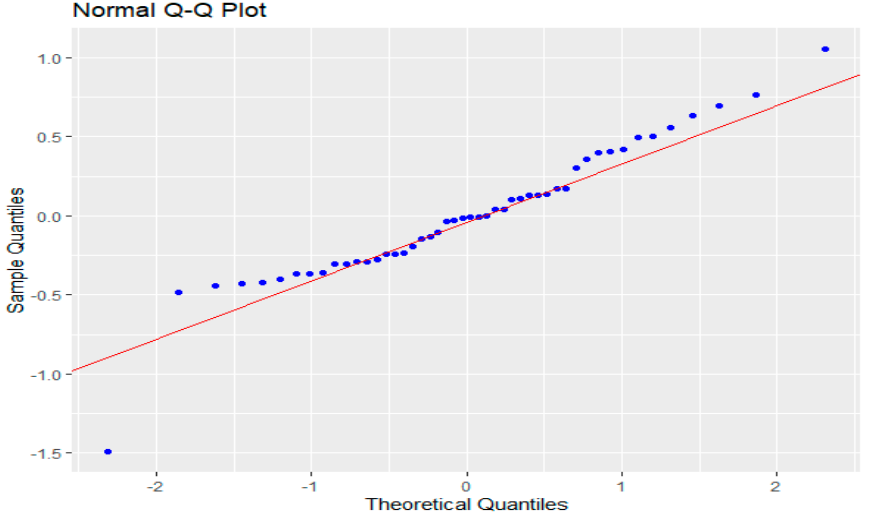
Figure 6. Residuals normality plot.